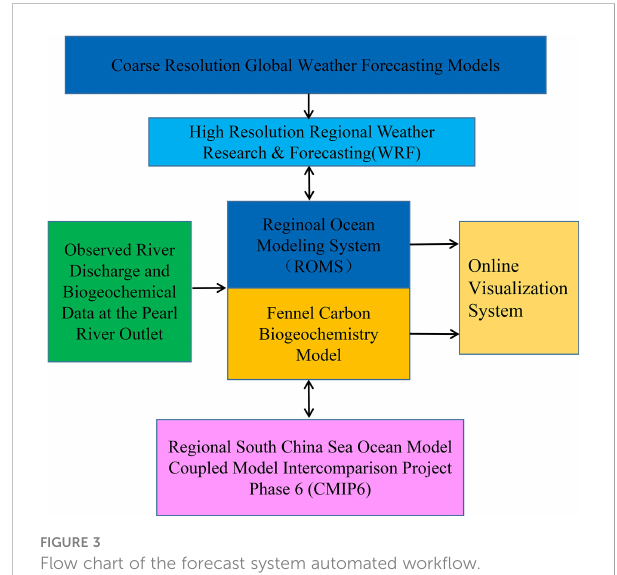
FIGURE 3 Flow chart of the forecast system automated work fl ow.